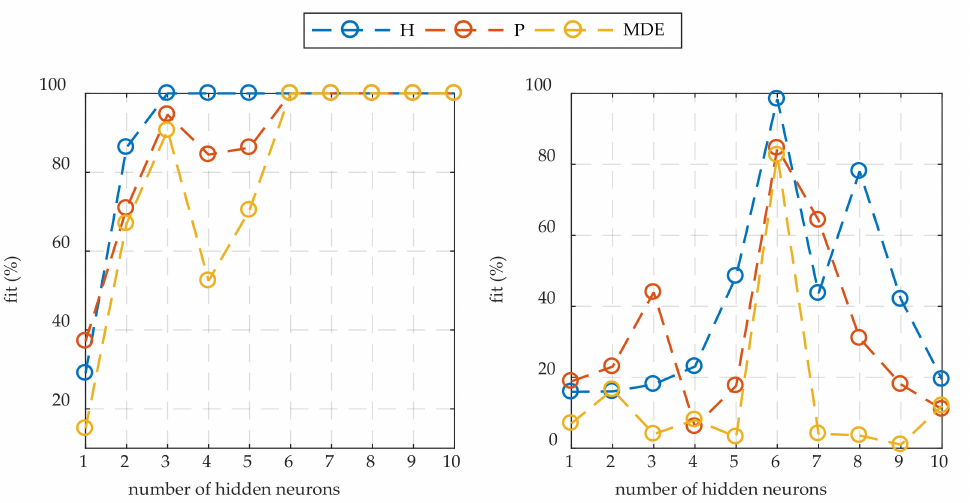
Figure 5. Influence of the number of hidden neurons on the fit index for learning (left) and testing (right)